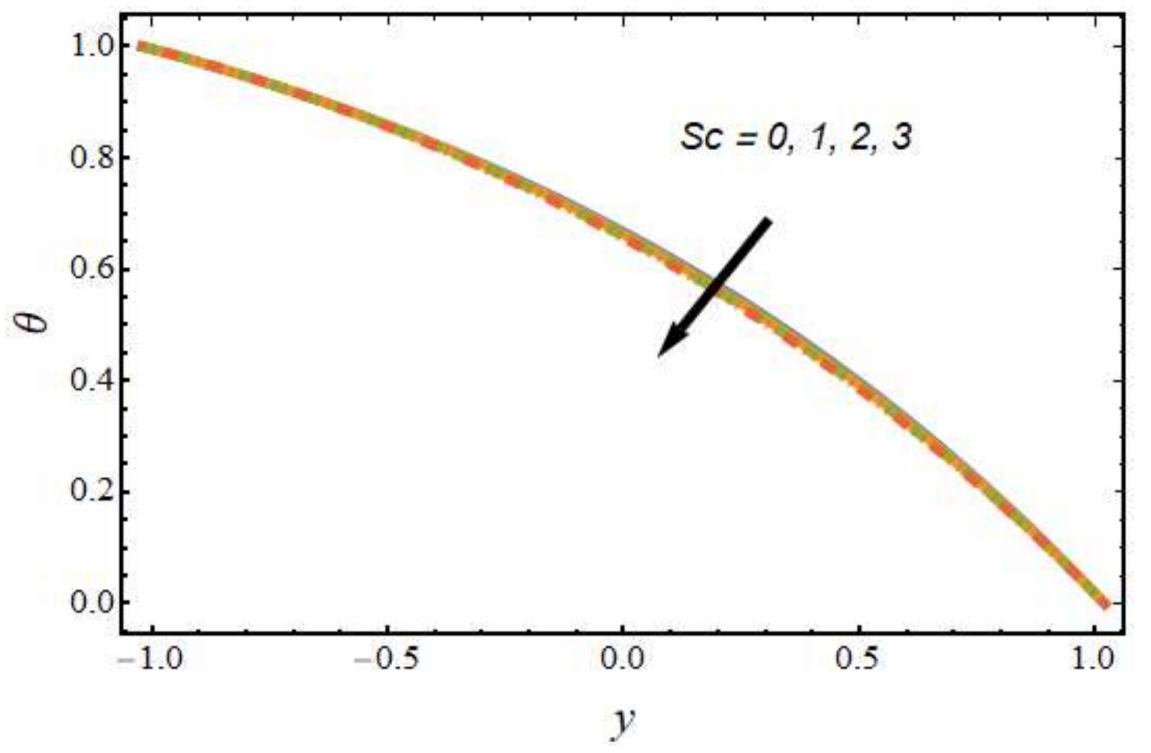
Figure 11. Nanoparticle temperature profile for various values of the Schmidt